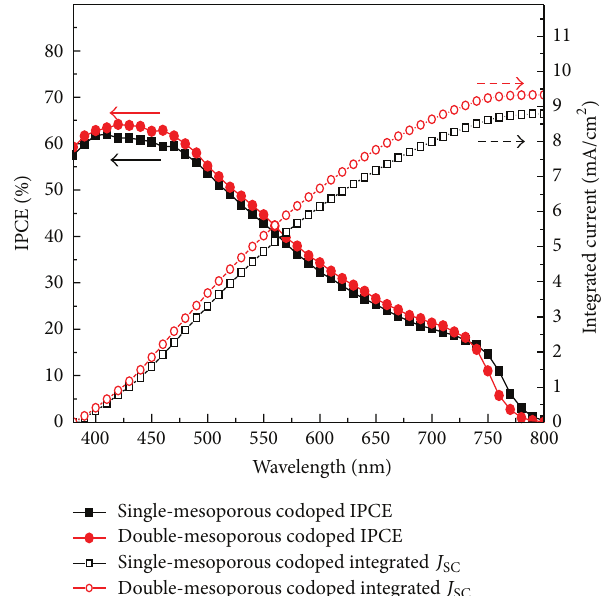
Figure 11: The IPCE curves and integrated photocurrent curves of the best-performing codoping-based PSCs with single- and double- mesoporous layer.